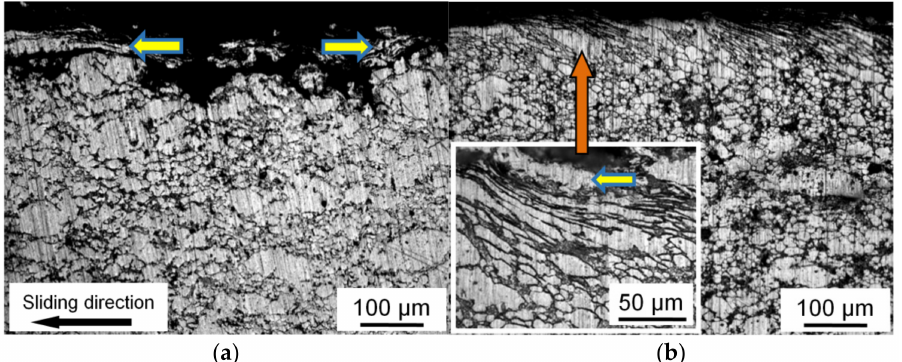
Figure 9. Optical images of the subsurface layer structure of the (Al–10Zn)–40Sn composite sample after dry friction against steel. Condition of the sample: ( a ) sintered, ( b ) subjected to subsequent HP . P = 5 MPa; V = 0.6 m/s. Delaminated wear particles are shown by horizontal